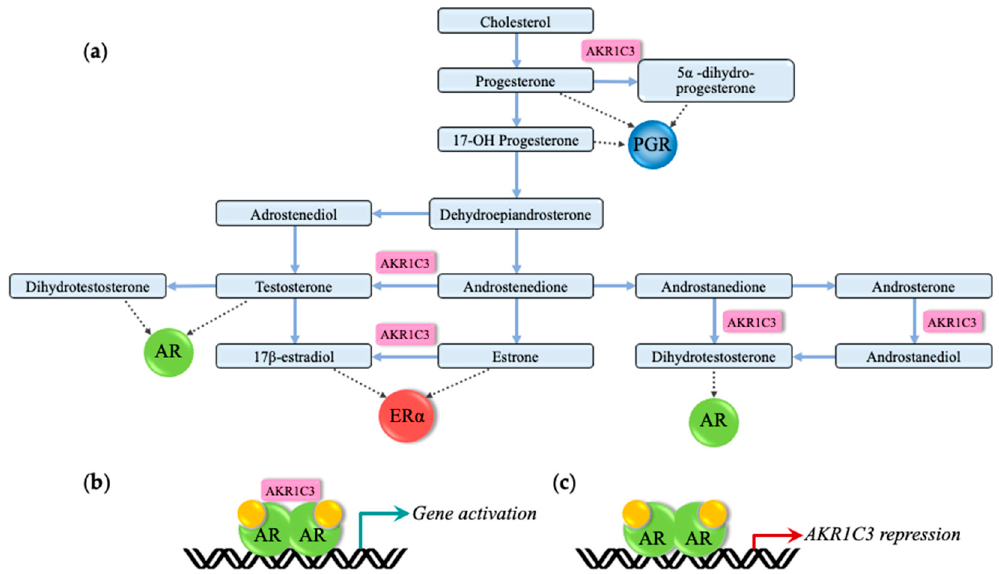
Figure 3. AKR1C3 influence on steroidogenesis and NHR-mediated gene regulation: ( a ) AKR1C3 influences NHR-mediated gene regulation through converting oestrone into the more potent ER α ligand 17 β -oestradiol, progesterone into the weaker PGR ligand 20 α -dihydroxyprogesterone, androstenedione into the weaker AR ligand testosterone, and androstanedione into the potent AR ligand DHT. Grey arrows represent the NHR corresponding to each ligand; ( b ) AKR1C3 regulates AR-mediated gene regulation through acting as a coactivator of AR and production of the AR ligands, testosterone, and DHT; ( c ) ligand-bound AR represses AKR1C3 gene expression [40].